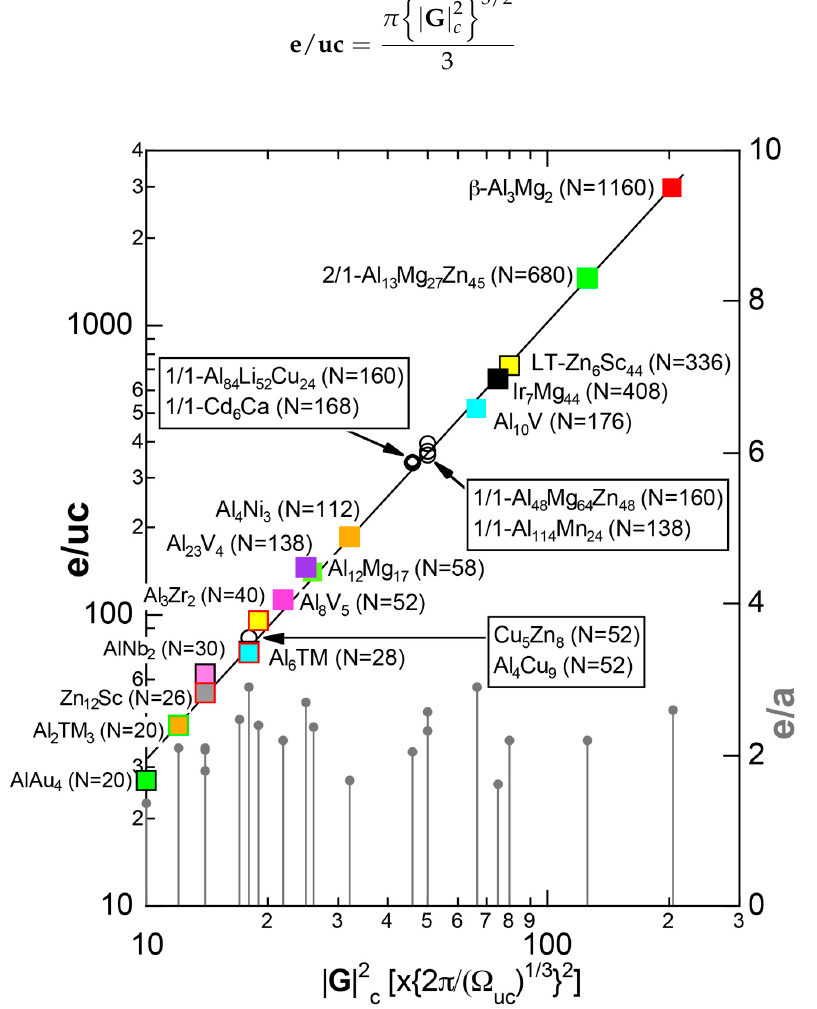
2 Figure 55. e/uc versus | G | 2 diagram on a log-log scale for pseudogap-bearing Al-, Zn- and Figure 55. e/uc versus G diagram on a log-log scale for pseudogap-bearing Al-, Zn- and Cd-based c c Cd-based compounds [11]. The NFE line (black) with a slope of 3/2 can be well fitted to all the compounds [11]. The NFE line (black) with a slope of 3/2 can be well fitted to all the compounds, compounds, regardless of the chemical bond-types involved. The critical reciprocal lattice vector | G | 2 regardless of the chemical bond-types involved. The critical reciprocal lattice vector G (cid:110) (cid:111) 2 is expressed in units of 2 π / Ω 1/3 uc , where Ω 1/3 uc represents the effective lattice constant for any 1/3 Ω crystals. The interference condition given by Equation (20) has been referred to as the “ 3/2-power law ”. 1/3 { } 2 , where in units of 2 π / Ω represents the effective lattice constant for any crystals. The uc uc No correlation is found between | G | 2 and e/a , which is plotted using the ordinate in the right-hand c interference condition given by Equation (20) has been referred to as the “ 3/2-power law ”. No 2 and e/a , which is plotted using the ordinate in the right-hand side. correlation is found between G c We have emphasized the need of classifying pseudogap-bearing isostructural compounds into 2 . Figure 56 is constructed to show how the data for families of gamma- subgroups with respect to G c